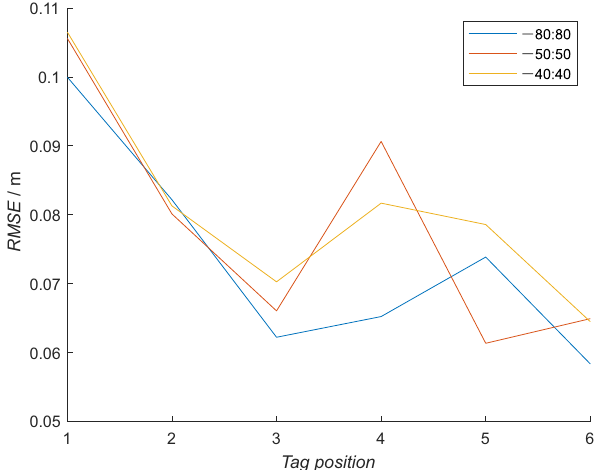
Figure 17. RMSE for all six tags’ poses with reduced training data for the neural network. From orig- inal − 80 to 80-degree elevation span, two smaller data sets were made: from − 50 to 50 and from − 40 to 40-degree elevation span.